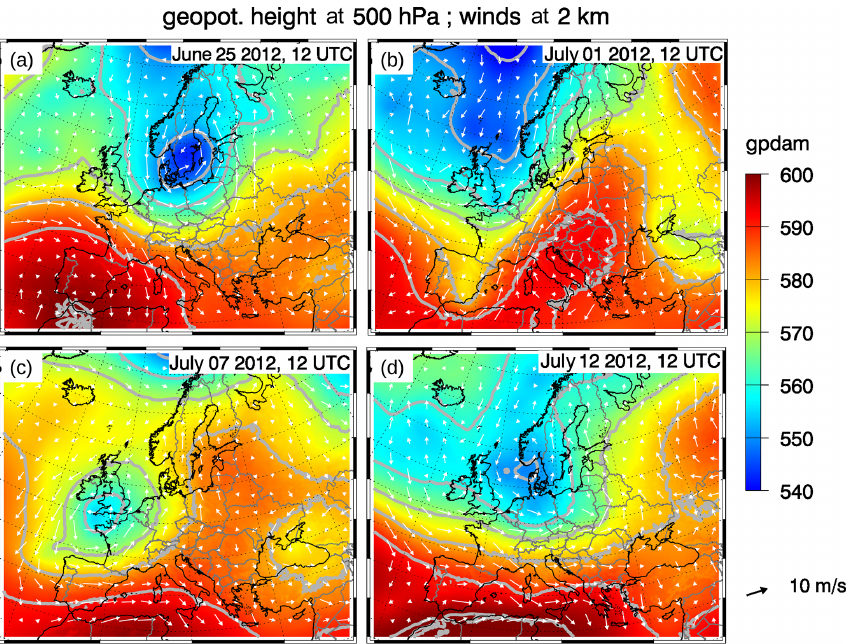
Figure 1. Geopotential height at 500hPa (color coded+isolines) and horizontal winds at 2km height (arrows) during the PEGASOS campaign in the Po Valley as simulated by WRF (initialized with IFS reanalysis; setup denoted as “reference” later